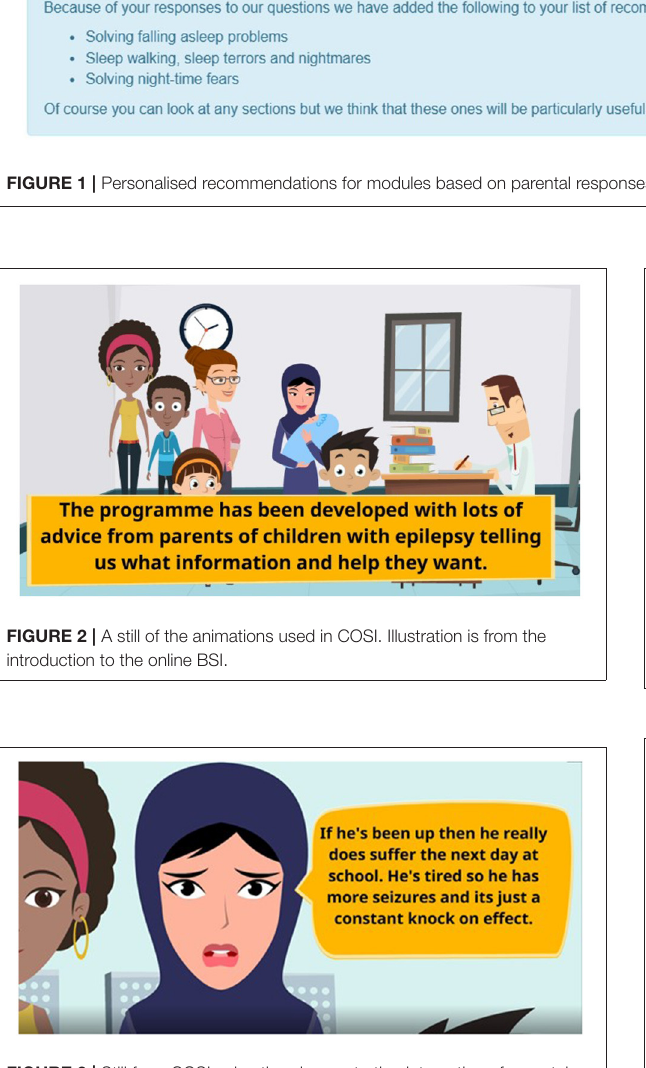
FIGURE 3 | Still from COSI animation demonstrating integration of parental perspective (quote).